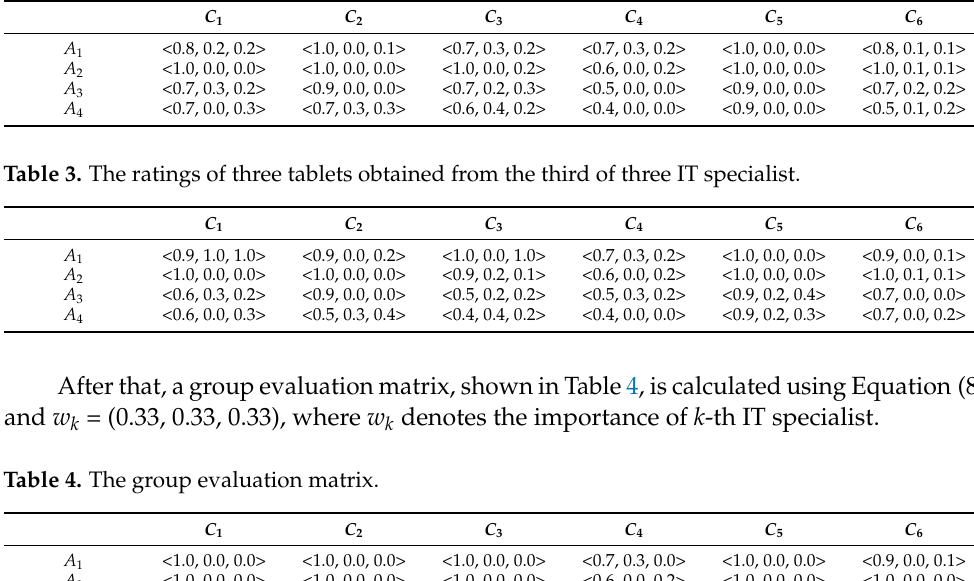
Table 2. The ratings of three tablets obtained from the second of three IT specialist.